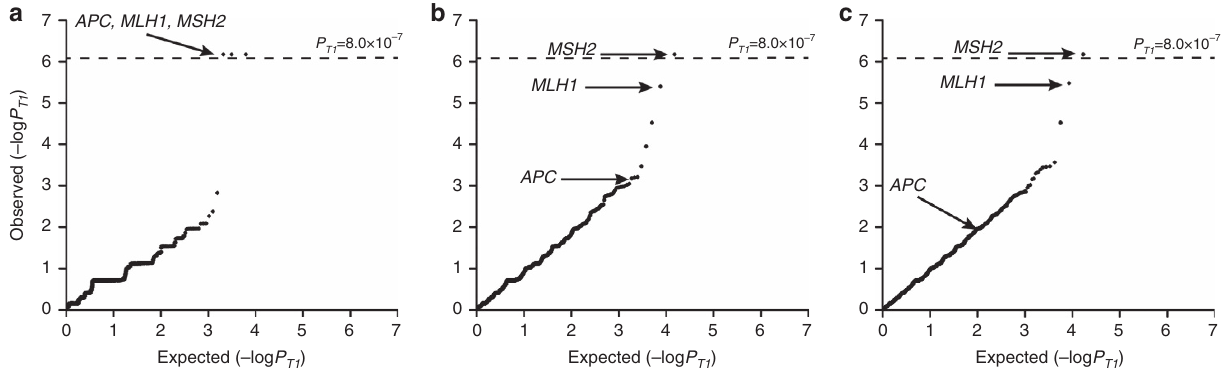
Figure 2 | Quantile–quantile plot of the T1 burden test results applying three different variant classifications. ( a ) Class 1, disruptive; ( b ) Class 2, predicted damaging; ( c ) Class 3, all non-synonymous variants. MLH1 , MSH2 and APC genes annotated. Dotted line corresponds to P T1- value of 8.0 (cid:2) 10 (cid:3) 7 .